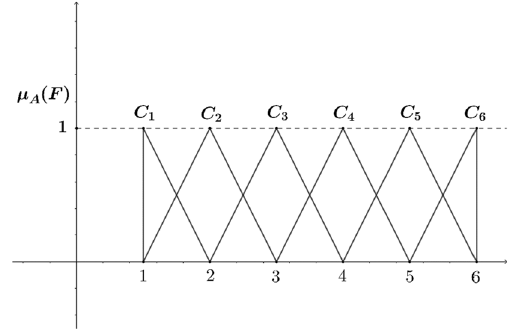
Fig. 3 Graphic scale of the proposed Fuzzy-MACBETH